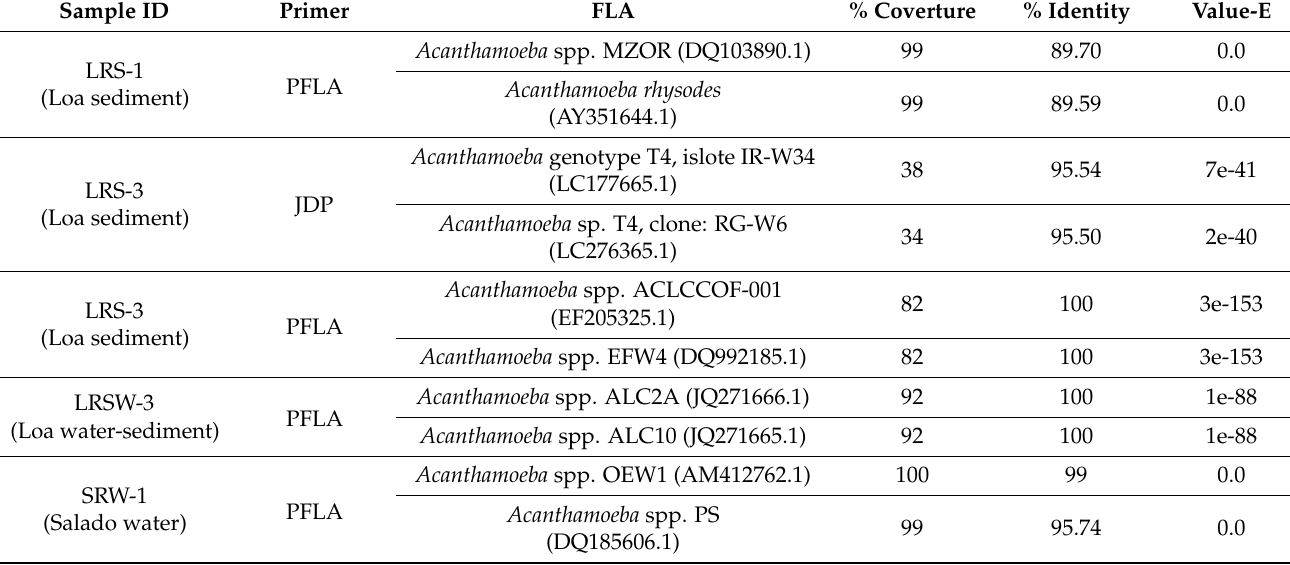
Table 2. Identification of Atacama FLA by BLASTn analysis. Acanthamoeba accession numbers from NCBI database are shown in parenthesis.